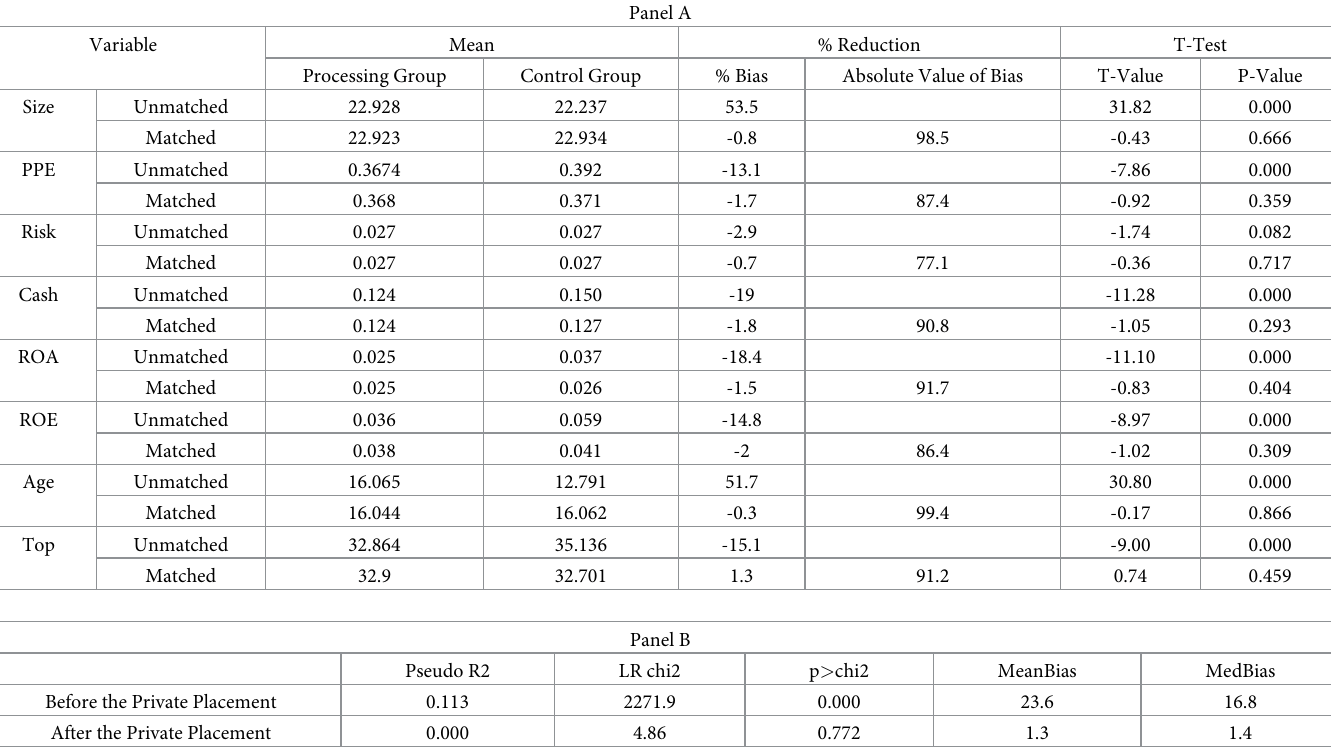
Table 3. Propensity score matching